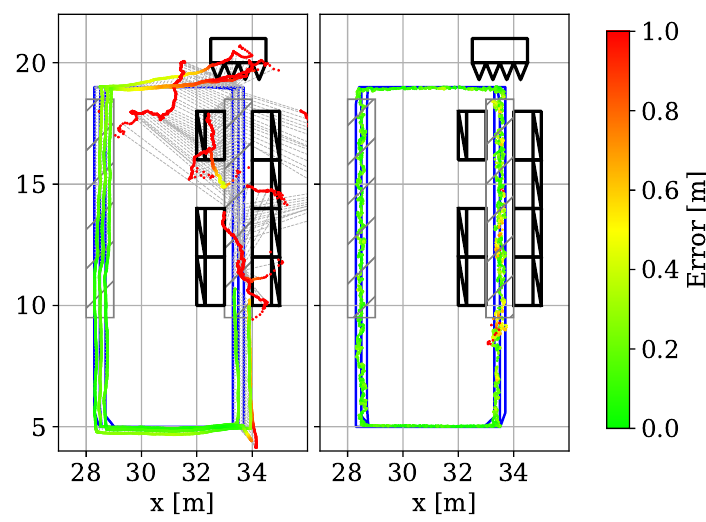
Figure 14. Results with multipath scenario